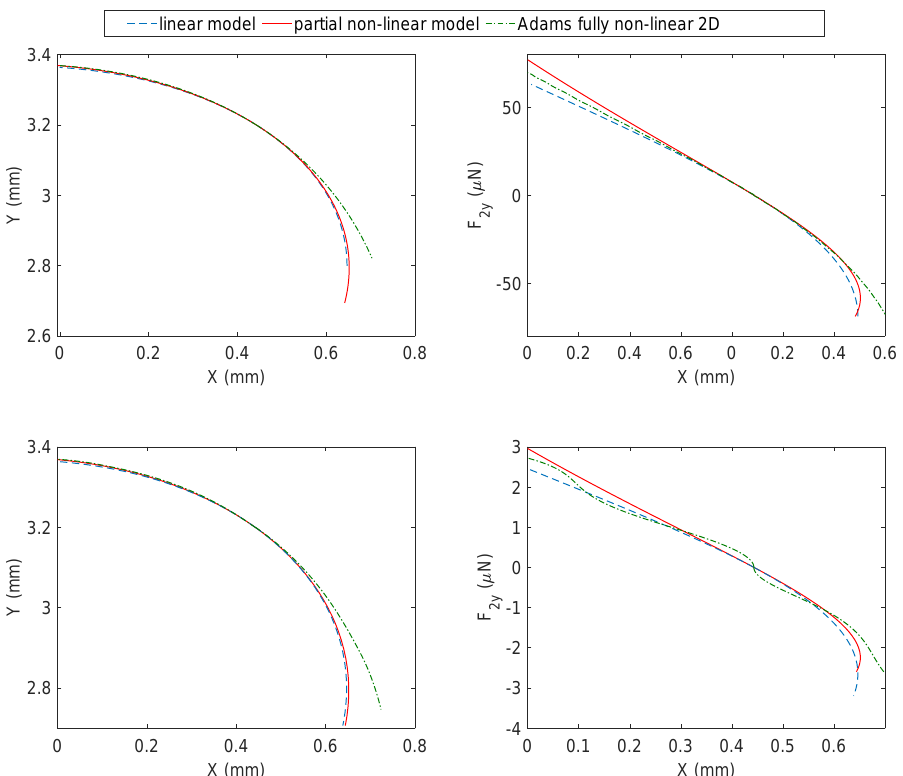
Figure 9. Model comparison in terms of workspace and actuation forces. Left subplot: end-effector trajectory in an opening–closing movement; right subplot: actuation force vs. x -coordinate of the end-effector during the opening–closing